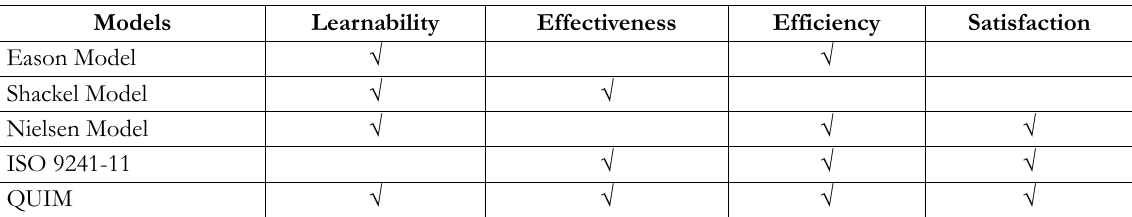
Table 1. The common attributes found in some well-known usability models